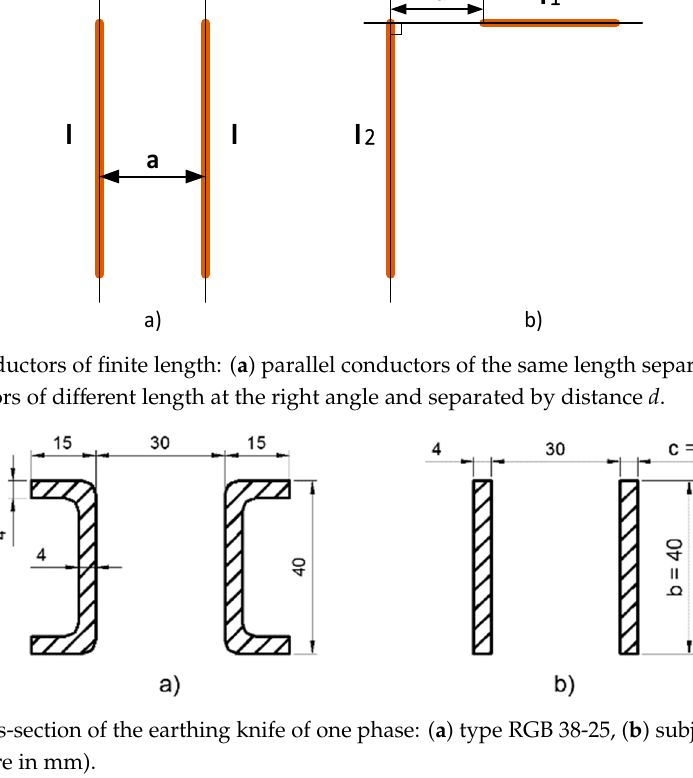
Figure 3. Top view of the earthing switch—red lines represent current lines, s1–s5 represent segments for force calculation on conductors at right angle, L11–L32 represent designations of each earthing knife.